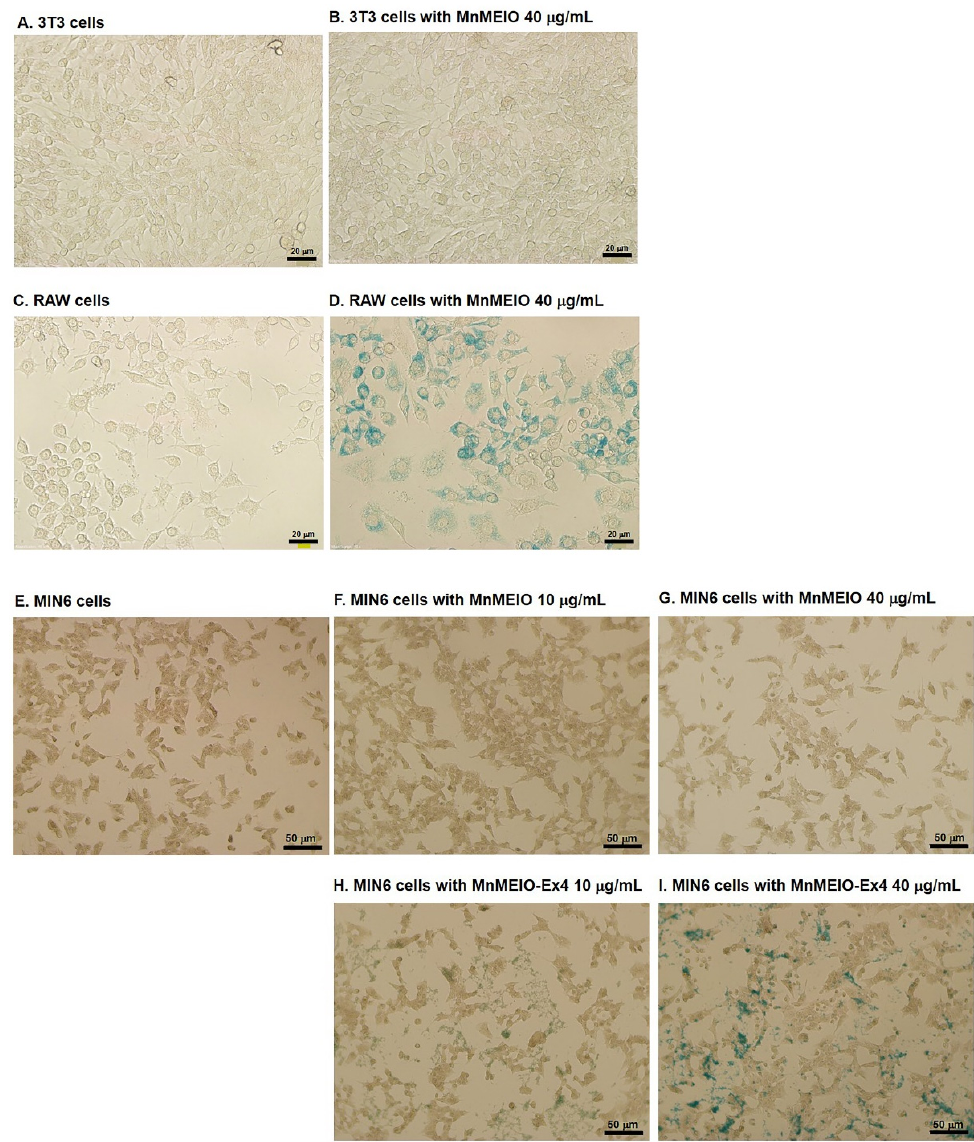
Figure 4. Cellular uptake of MnMEIO and MnMEIO-Ex4 NPs NPs. The 3T3 fibroblasts ( A ) and RAW macrophages ( C ) were incubated overnight with MnMEIO NPs 40 μ g/mL ( B , D ). MIN6 cells ( E ) were incubated overnight with MnMEIO NPs 10 μ g/mL ( F ), 40 μ g/mL ( G ) and MnMEIO-Ex4 NPs 10 μ g/mL ( H ), 40 μ g/mL ( I ). The intracellular iron content was examined by Prussian blue staining.